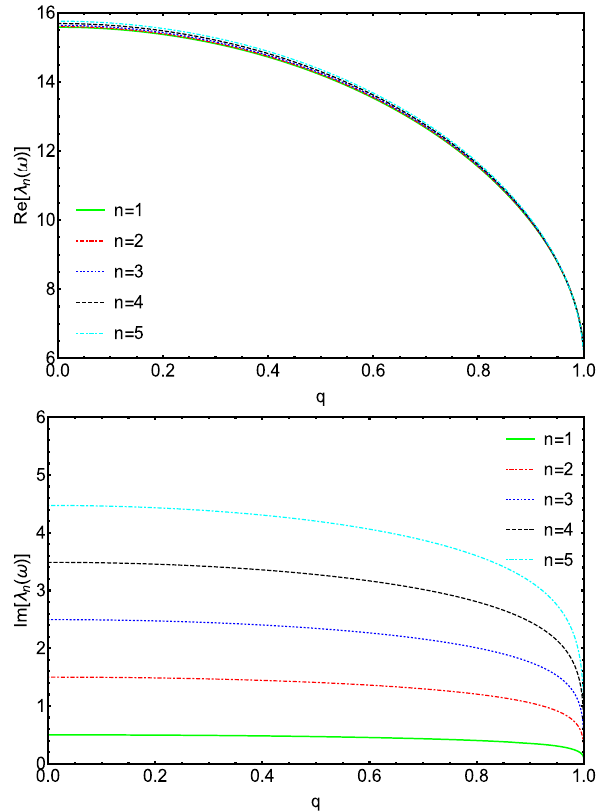
Fig. 3 Real and imaginary parts of the first five Regge poles (with ω M = 3 . 0) as functions of q